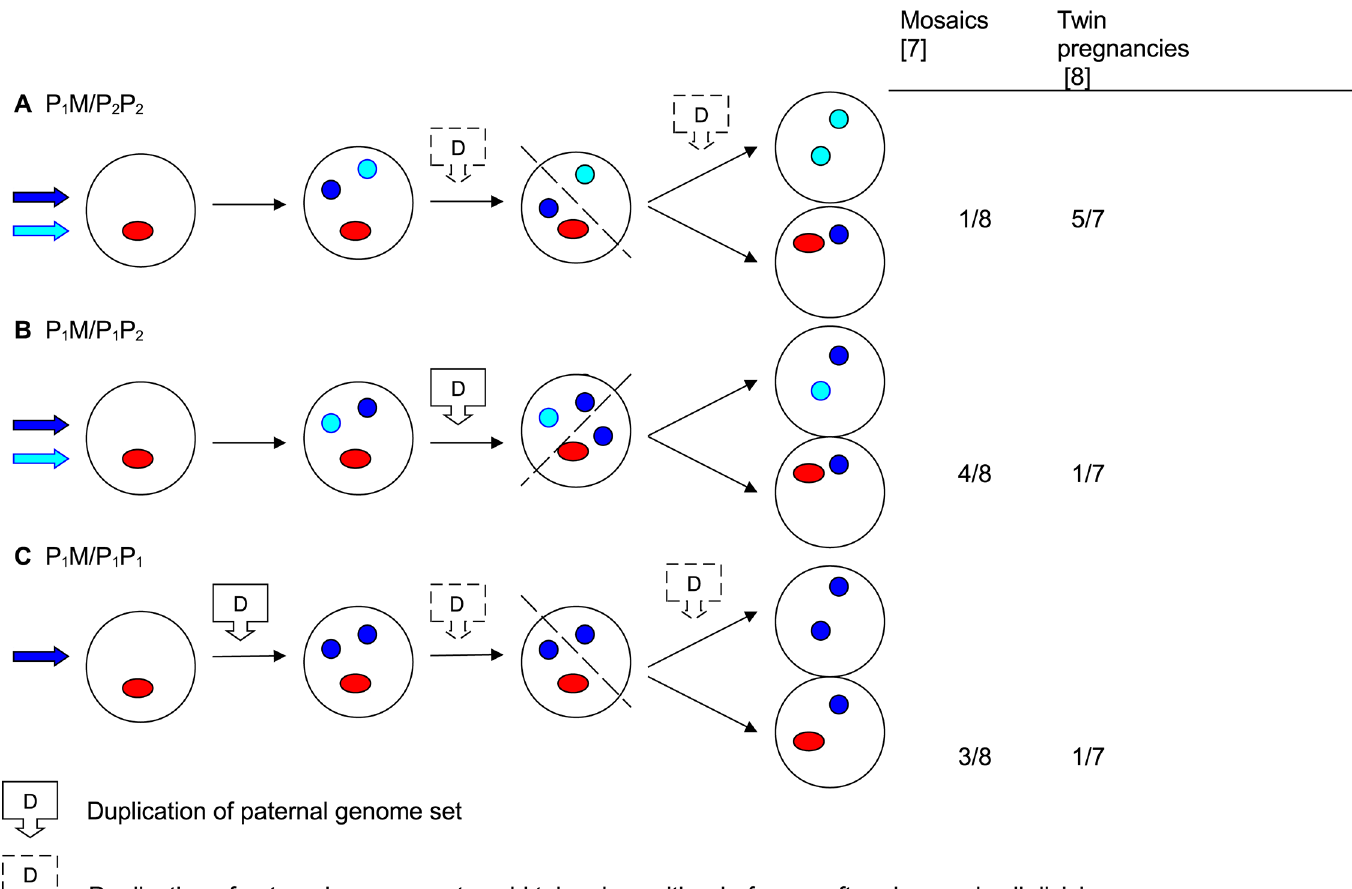
Fig 2. reproduced [7]. Possible fertilizations, endoreduplications, and abnormal cell divisions in mosaic hydatidiform moles (HMs), and twin gestations including an HM. (a) Fertilisation by two sperms; one giving rise to the paternal genome set in the diploid biparental cell population, the other giving rise to both genome sets in the diploid androgenetic cell population via endoreduplication. (b) Fertilisation by two sperms; one giving rise to one of the paternal genome sets in the diploid androgenetic cell population, the other contributing one genome set to both cell populations via endoreduplication. (c) Fertilisation by one sperm that via two endoreduplications gives rise to three identical paternal genome sets, of which two constitute the genome of the diploid androgenetic cell population and one is the paternal genome set in the diploid biparental cell population.